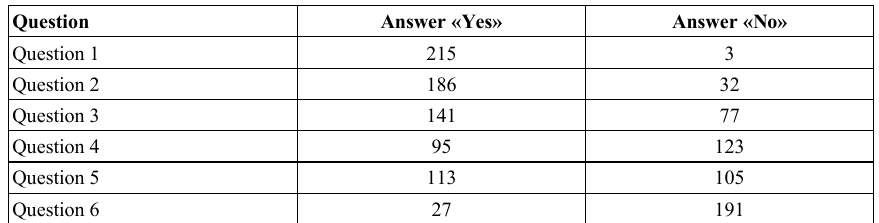
Table 1. Quantitative results of students'